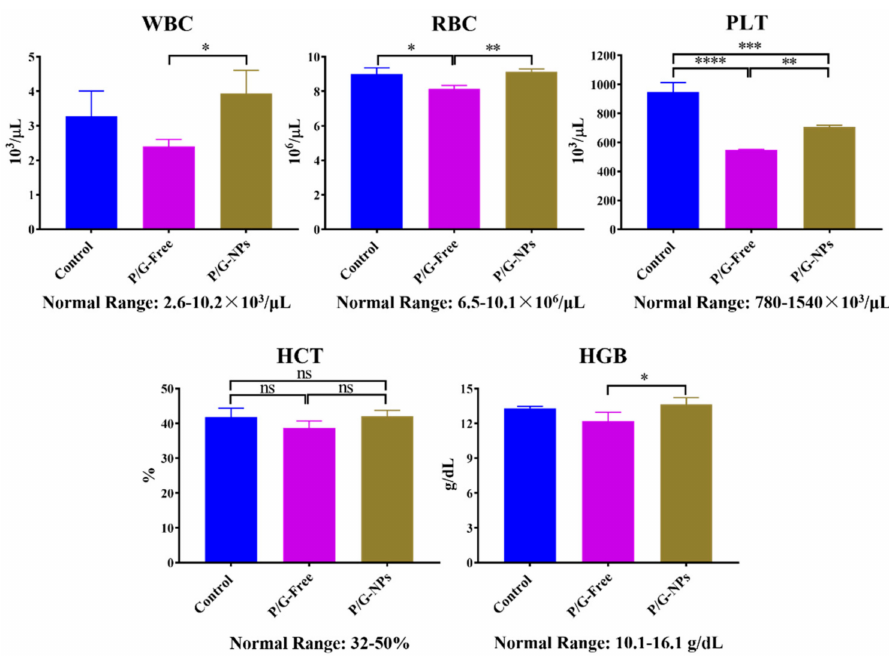
Figure 11. Hematology assay of the PBS, P/G-Free, and P/G-NPs groups ( n = 3). **** p < 0.0001, *** p < 0.0002, ** p < 0.01, * p < 0.05, ns: not significant. Table 3. Serum levels of AST, ALT, LDH, creatinine, and BUN after three injections in mice ( n = 5). AST 1 (U/L) ALT 2